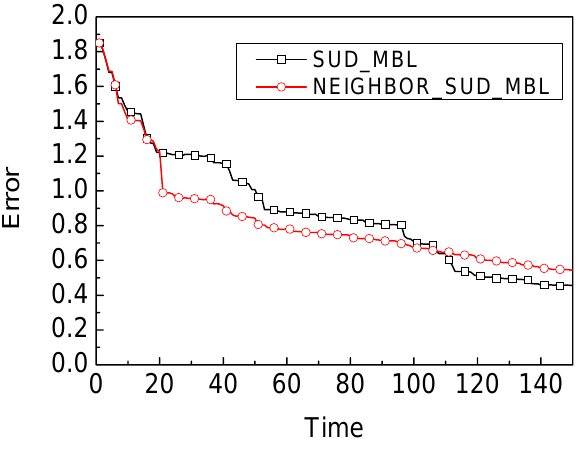
Figure 7 . Comparison of neighbor’s impact when (Time ≥ 20) and (Time mod 20 = 0).